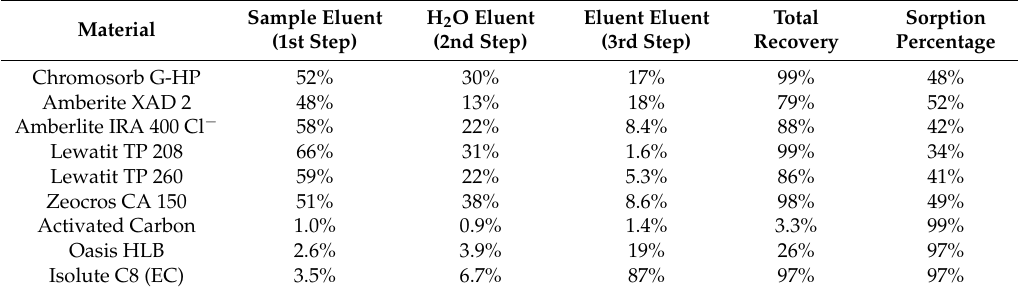
Table 3. Total phenolics determined in the eluents in comparison with the total phenolics loaded to the SPE